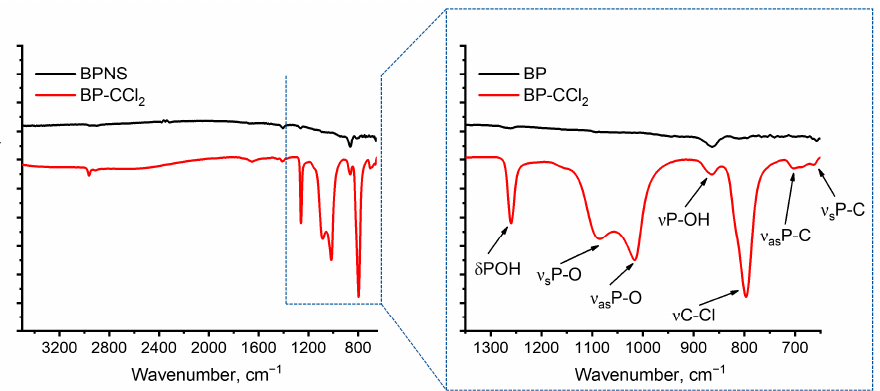
Figure 6. FT ‐ IR spectra of BPNS and BP–CCl 2 . The inset contains the enlarged FT ‐ IR spectra in the Figure 6. FT-IR spectra of BPNS and BP–CCl 2 . The inset contains the enlarged FT-IR spectra in the region of 650–1350 cm − 1 . region of 650–1350 cm − 1 .